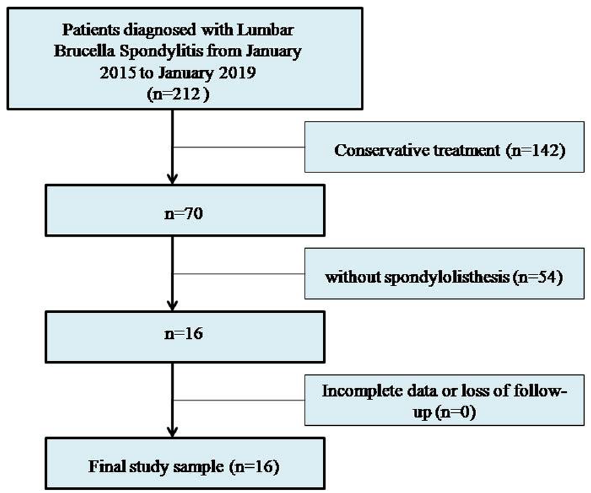
Figure 1. Flowchart showing study